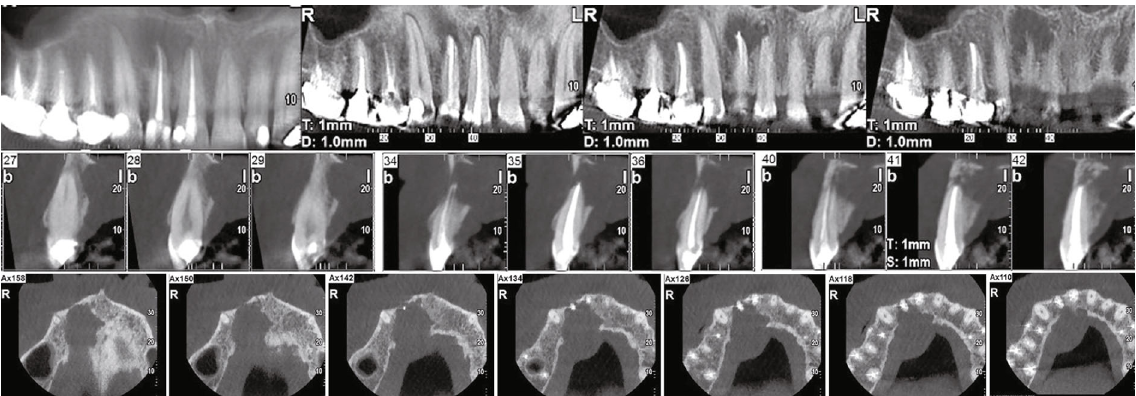
Figure 2: CBCT scan of the maxillary anterior region showing a large bony defect surrounding the periapex area of tooth #12, which extended from the distal aspect of the root of tooth #13 toward the mesial wall of the root of tooth